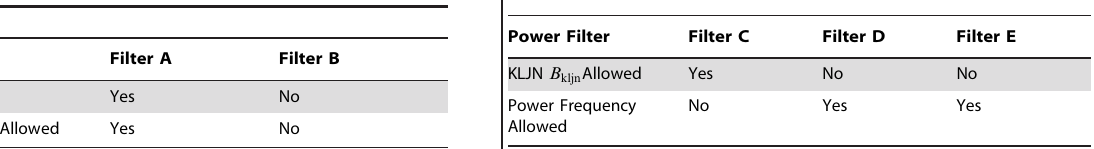
Table 1. Truth table of the KLJN Filters in State 1 (inactive host).